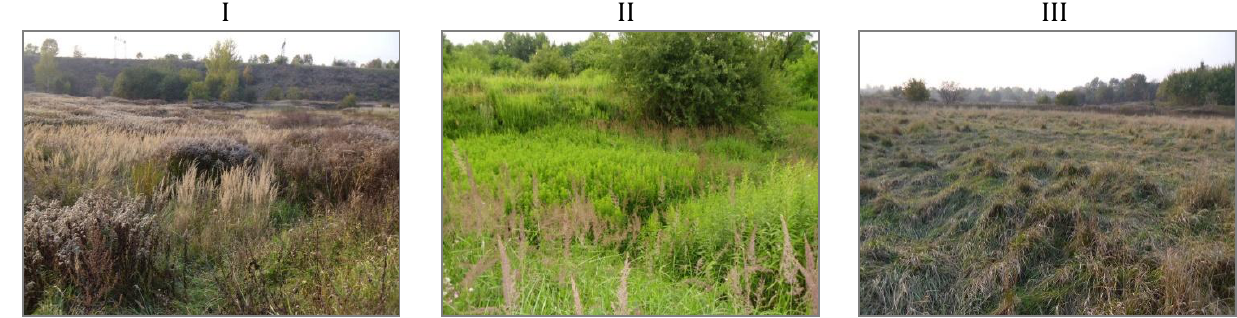
Fig. 2. Research area with occurrences of Calamagrostis epigejos : plots I – 30%, II – 15%, III – 5% ( S. Kopczyńska , 2011)